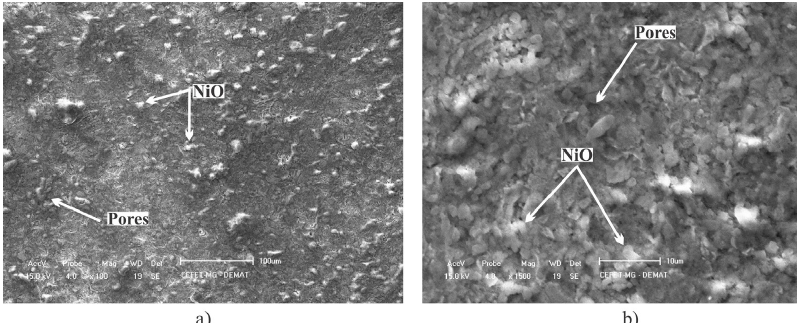
Figure 4. Sample “J1” coated with Ni/NiO. 180X (a) and 1500X (b).